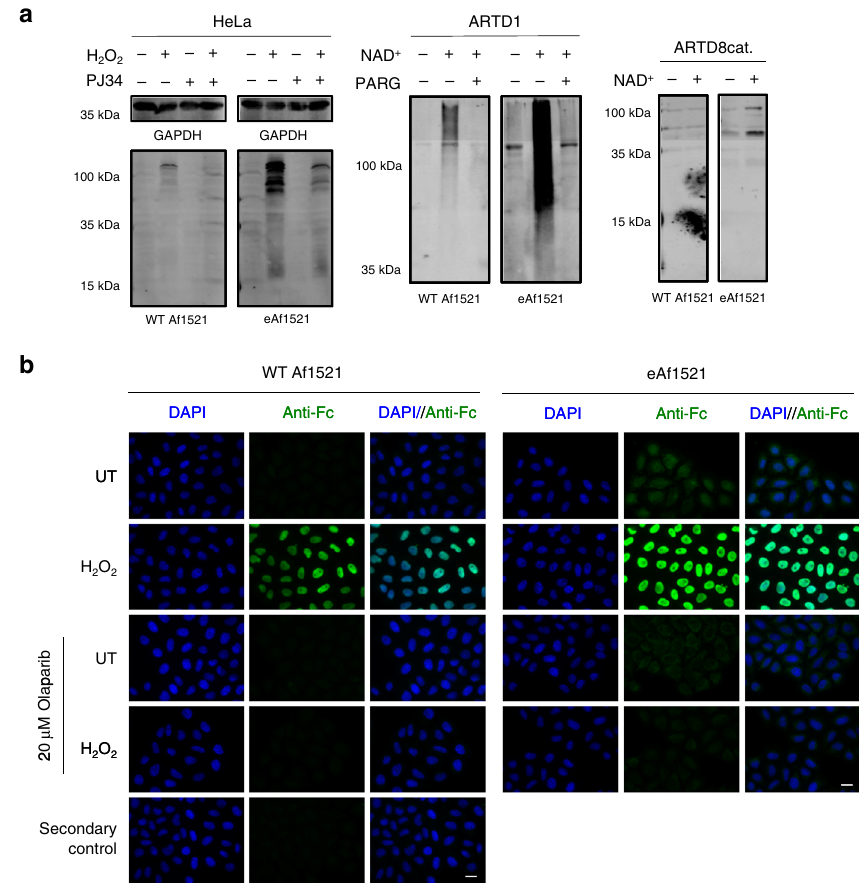
Fig. 4 Fc-eAf1521 is more sensitive in detecting ADP-ribosylation than Fc-WT Af1521. a Immunoblot analyses of different substrates with either Fc- eAf1521 or Fc-WT Af1521 (untreated and H 2 O 2 -treated HeLa cells, including PJ34 treatment as control for ADP-ribosylation inhibition; unmodi fi ed, poly- ADP-ribosylated and mono-ADP-ribosylated ARTD1, and unmodi fi ed and mono-ADP-ribosylated ARTD8cat). Detection was performed with IRDye 680 goat anti-mouse antibody. Immunoblot analyses to be compared were performed at the same time and with the same exposure. The experiment was repeated independently ( n = 2) with similar results. b Immuno fl uorescence analysis of HeLa cells co-treated with H 2 O 2 and 20 μ M olaparib stained with either Fc-WT Af1521 or Fc-eAf1521, followed by Alexa 488-labeled goat anti-mouse antibody. The experiment was repeated independently ( n = 2) with similar results. Scale bar, 20 μ m. Source data are provided as a Source data fi